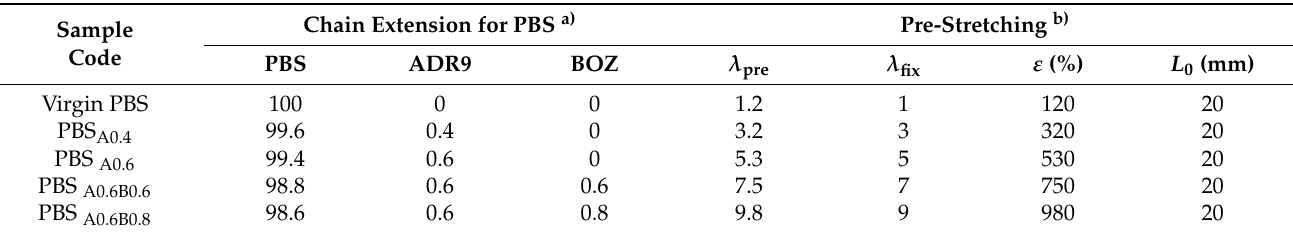
Table 1. Sample type, name abbreviation, and